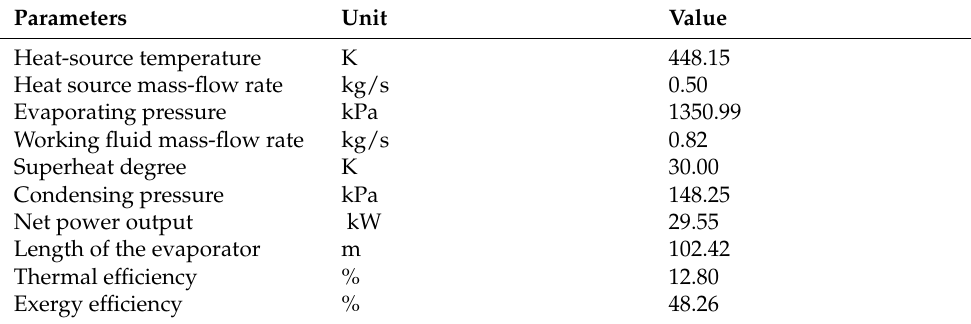
Table 2. Main parameters under the steady-state heat